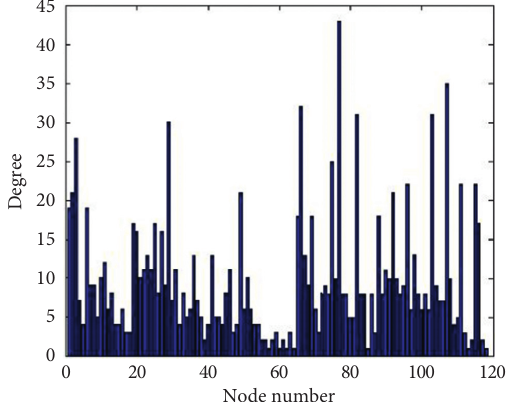
Figure 2: The degree of nodes.